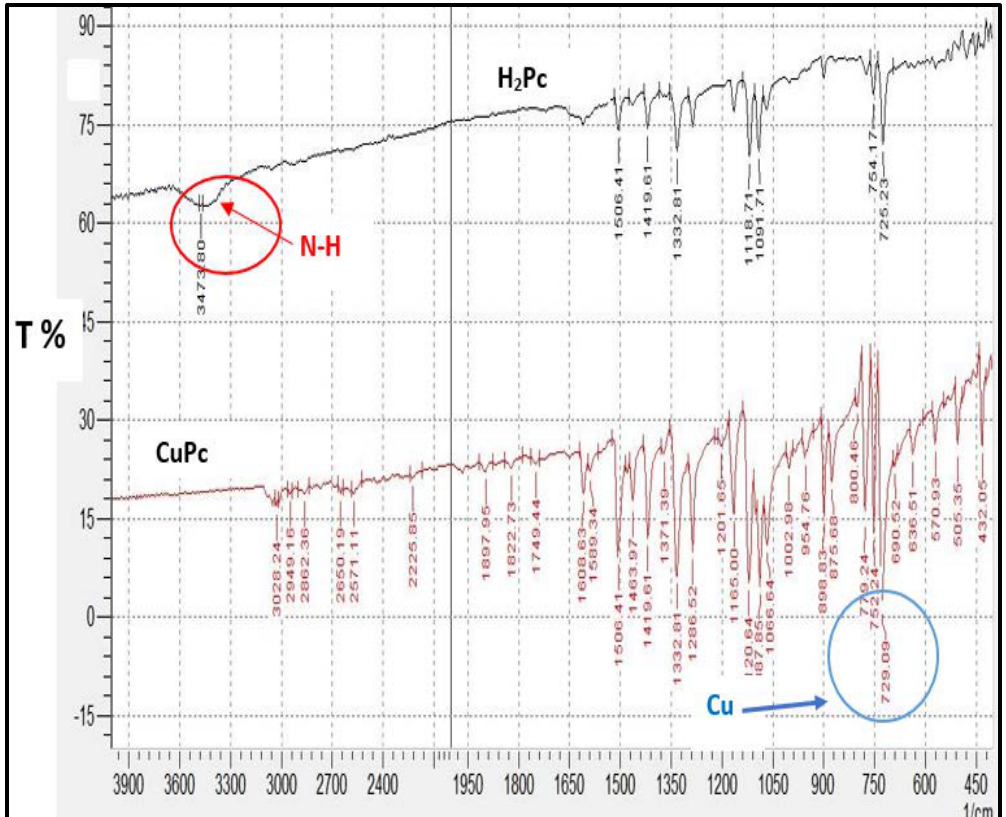
Fig.8: The FTIR spectrum of CuPc and metal Phthalocyanine spectrum (H